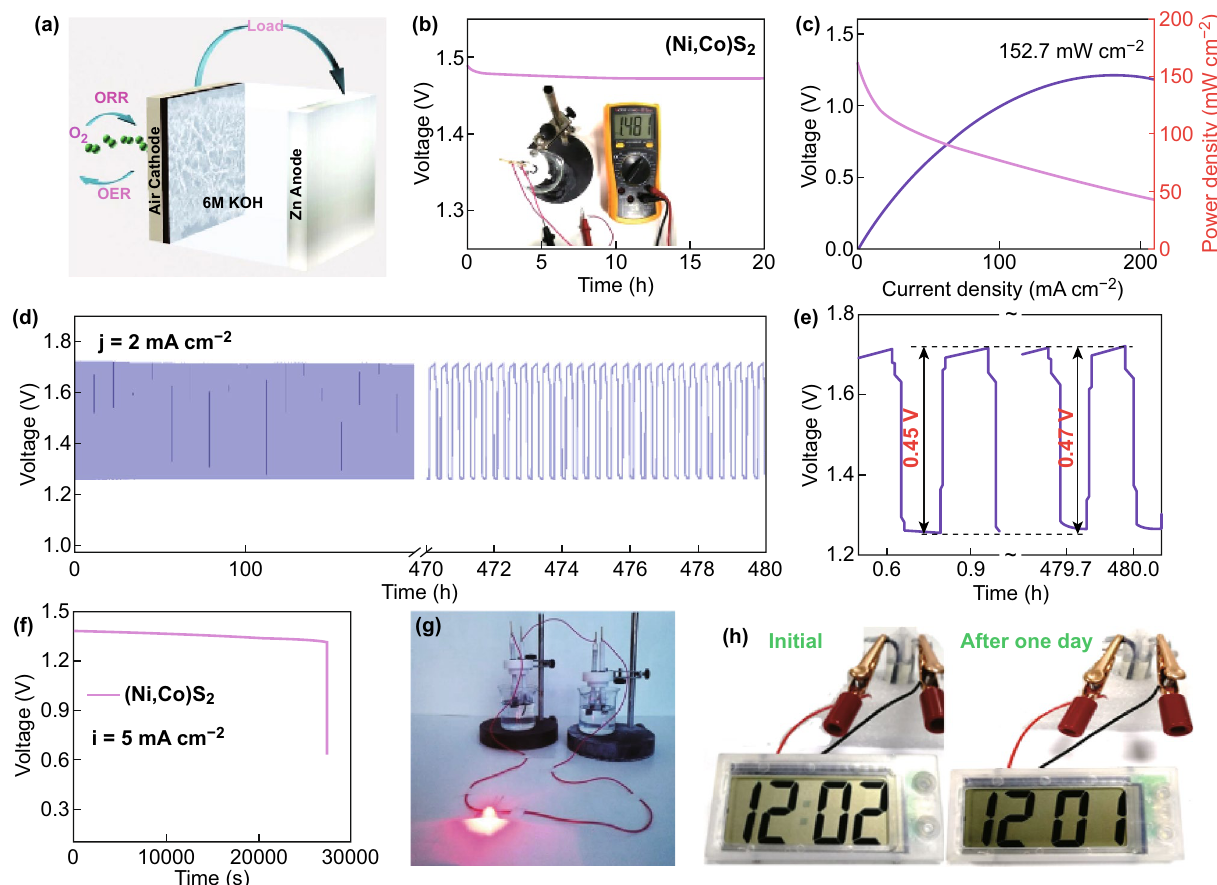
Fig. 5 a Schematic illustration of rechargeable Zn–air battery. b Open cell voltage curve and c polarization and power density curves of (Ni,Co)S 2 -based primary Zn–air battery. d Galvanostatic discharge–charge cycling curves at 2 mA cm −2 of the rechargeable Zn–air battery. e Charge–discharge efficiency of the Zn–air battery at the beginning and end. f Long-time discharge curves of (Ni,Co)S 2 -based Zn–air battery at 5 mA cm −2 . g Photograph of red LED powered by two (Ni,Co)S 2 -based Zn–air batteries. h Photographs of an electronic watch powered by the (Ni,Co)S 2 -based Zn–air